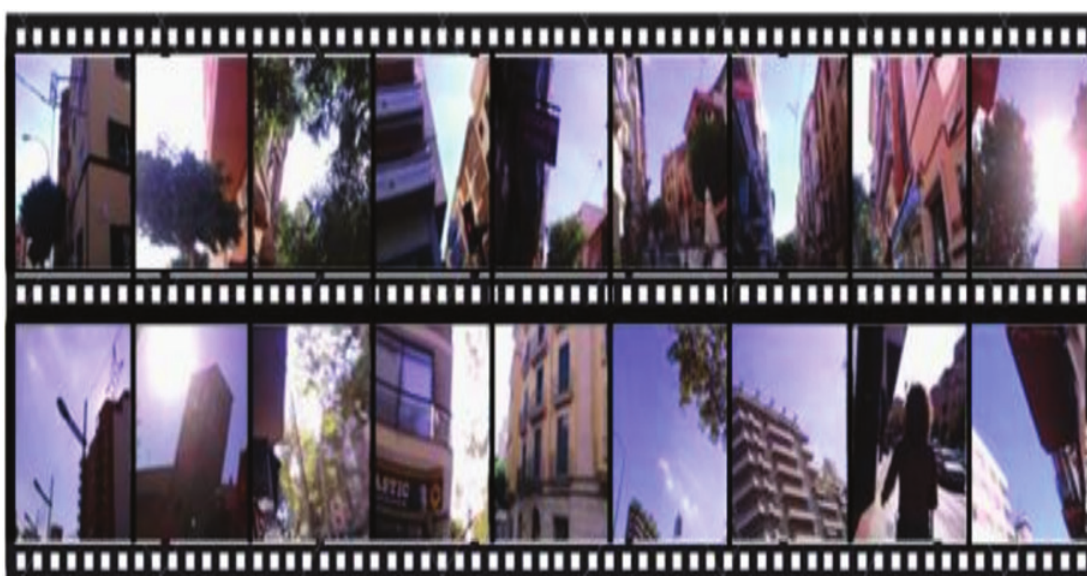
Figure 2: Example of sequence when walking in the street acquired by the Narrative Clip wearable